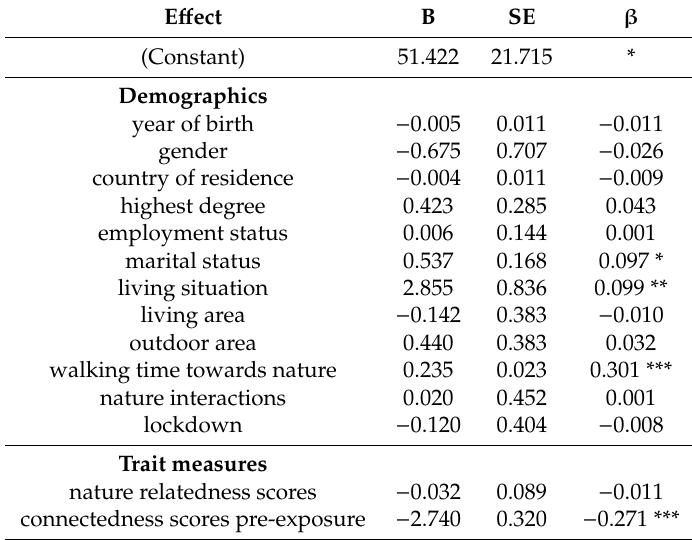
Table 3. Multiple regression model to predict Loneliness scores (* p < 0.05, ** p < 0.01, *** p < 0.001). E ff